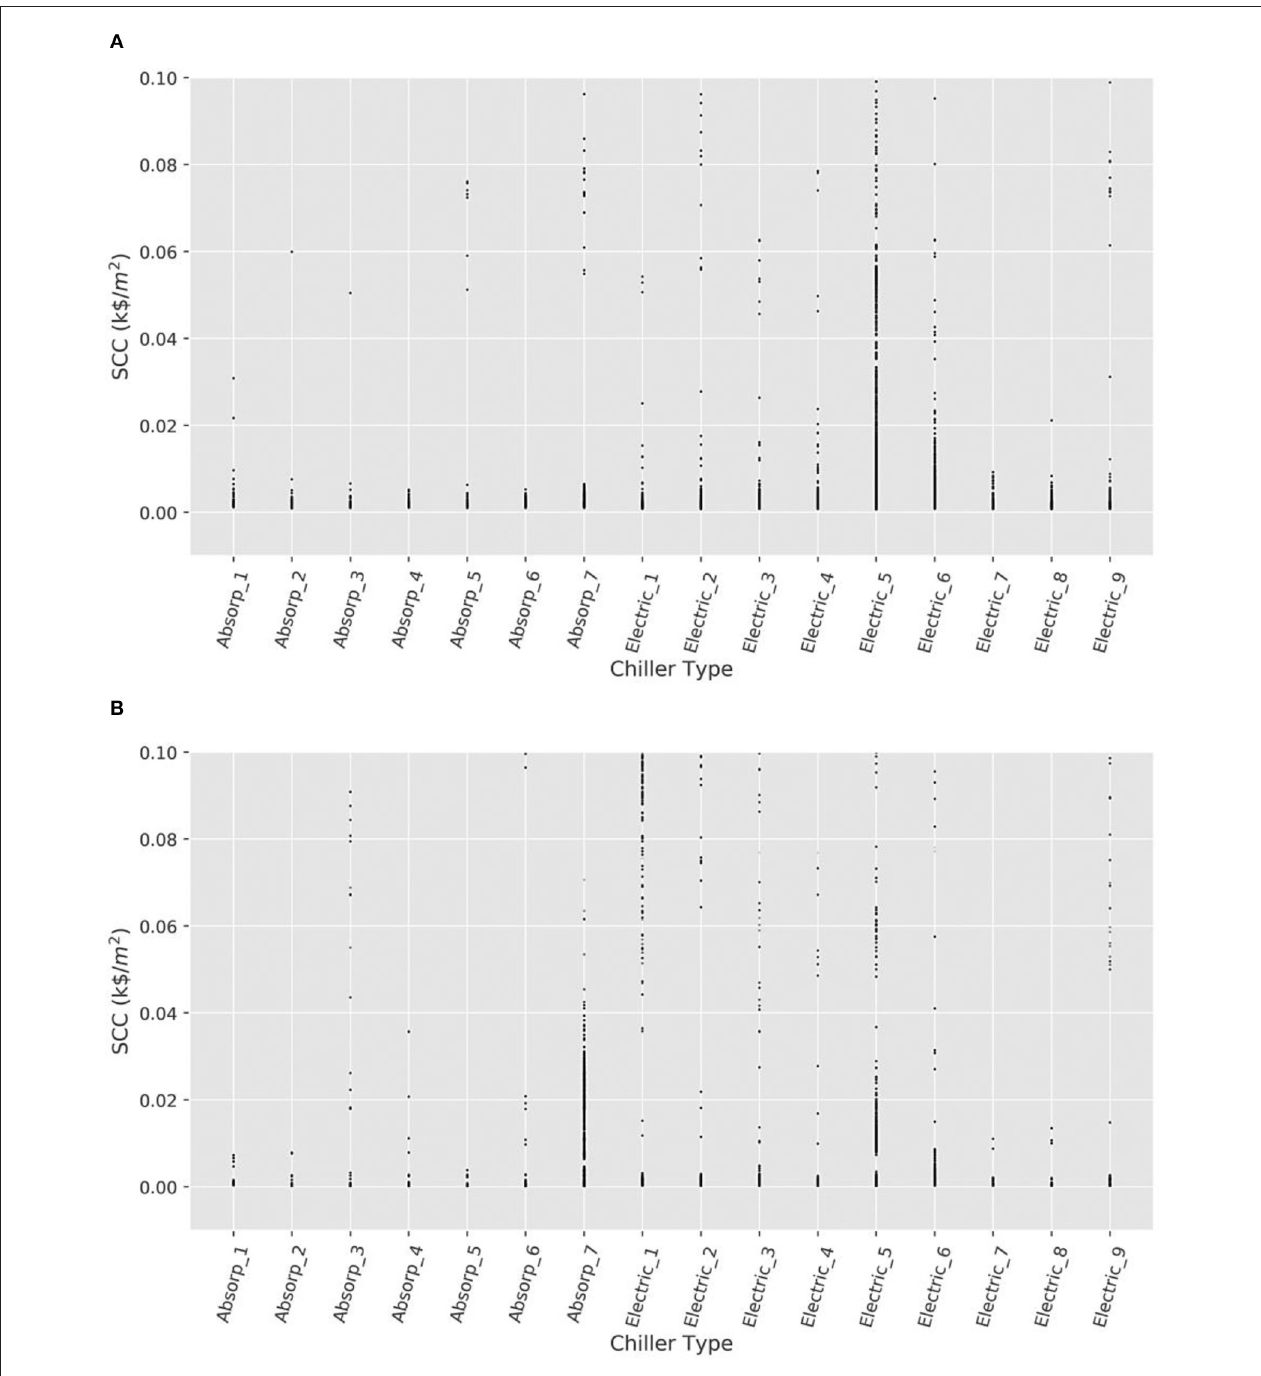
FIGURE 8 | Social cost of carbon vs. Chiller type for (A) scenario 1 and (B) scenario 2, across all individual neighborhoods with SCCs less than 0.1 k$/m 2 . Each neighborhood is represented by a single dot in the plot.